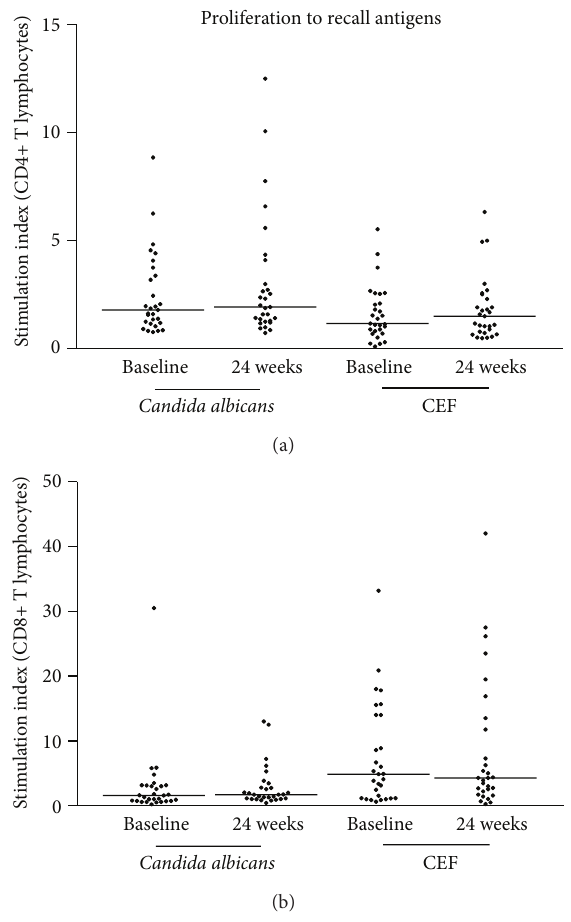
Figure 6: Lymphocyte proliferation toward Candida albicans and CEF antigens as performed at baseline (T0) and after 24 weeks of treatment (T2) in a representative group of 30 patients under therapy with etanercept (10), adalimumab (10), or infliximab (10). Stimulation indexes of CD4+ (a) and CD8+ (b)